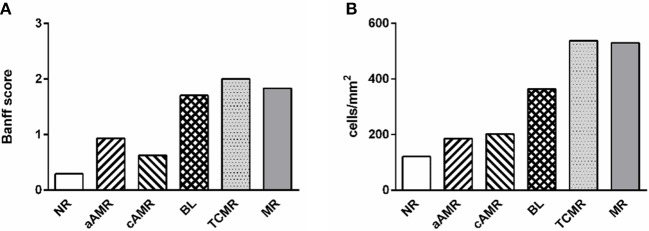
Comparison of two approaches to diagnosing rejection. Mean value of inflammation in every diagnostic category measured by the Banff score from 0 to 3 (A) and with the computer-assisted quantification technique performed in this study (B).